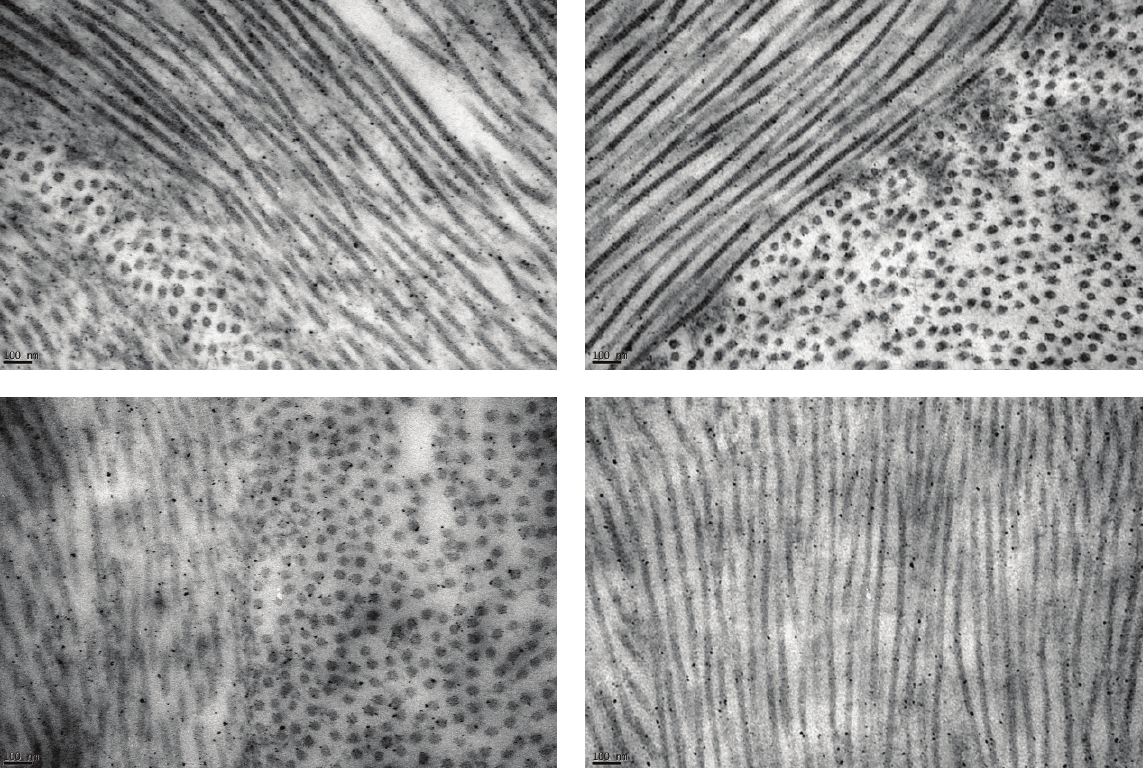
Figure 4. Images taken from transmissional electron microscopy of the corneas from groups (x100K); control (a), ozone (b), cross- linking (c), ozone-cross-linking (d), respectively. Collagen fibers and interlamellar spaces were examined by electron